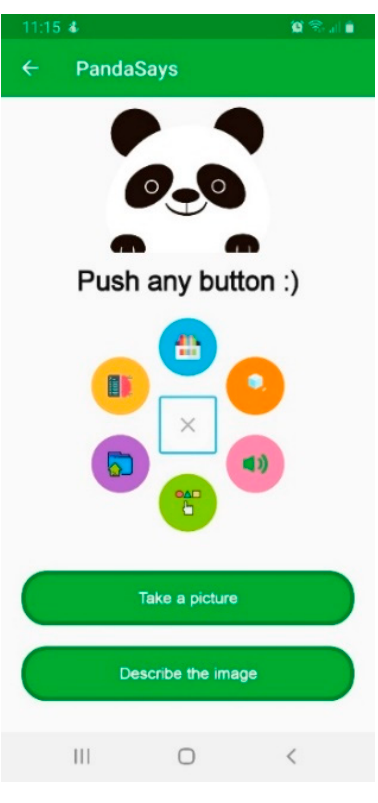
Figure 9. PandaSays menu with TalkBack application on.